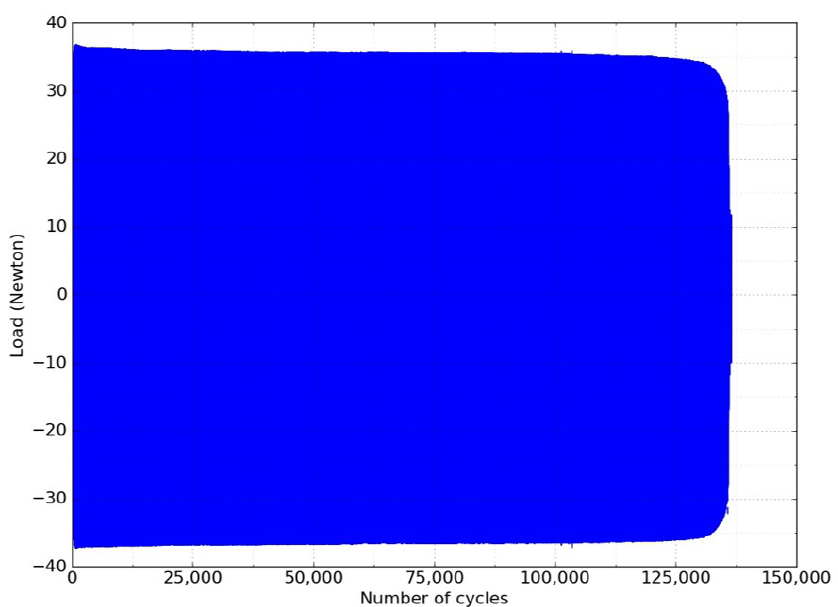
Figure 11. Nucleation and propagation stage of fine finished specimens, ( a ) wrought specimen displaced at 0.300 mm amplitude; ( b ) wrought specimen displaced at 0.225 mm amplitude; ( c ) SLM specimen displaced at 0.200 mm; ( d ) SLM specimen displaced at 0.175 mm amplitude.